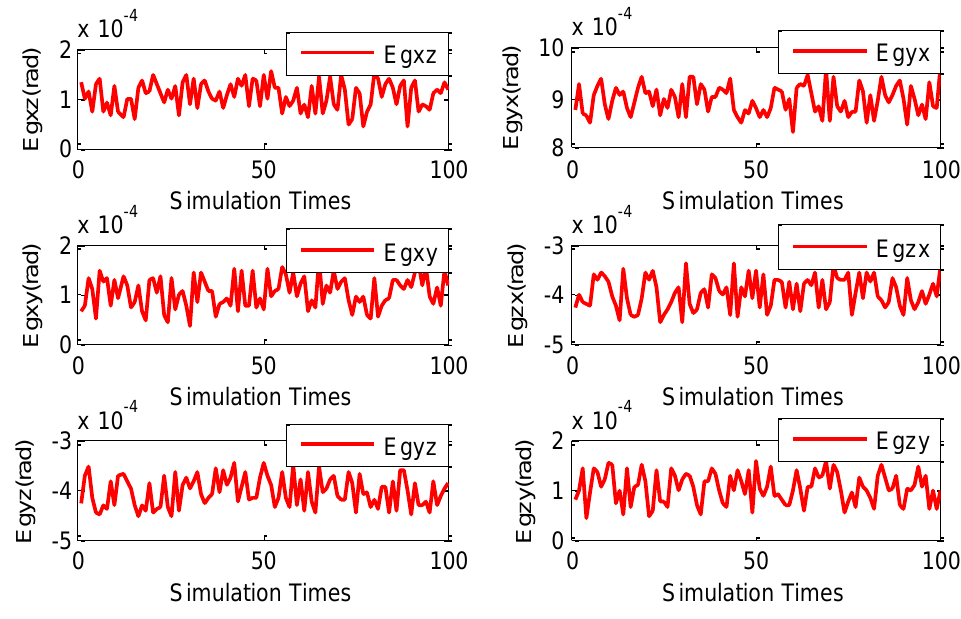
Figure 3. FOG misalignment errors MCS-NAFSA curves.